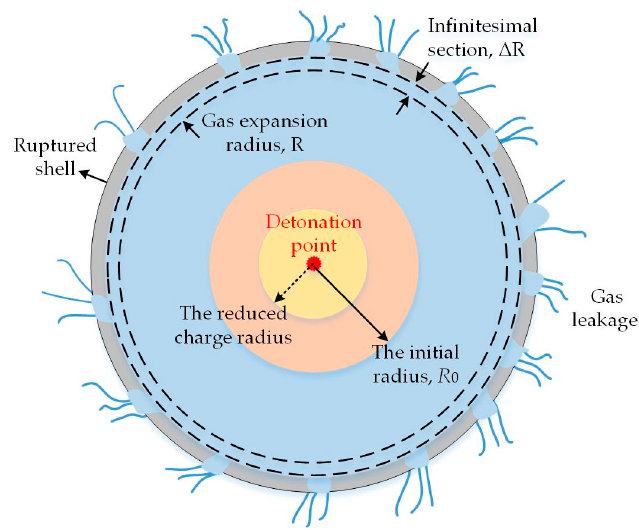
Figure 2. Illustration of locally isentropic expansion of detonation gas after shell ruptures.